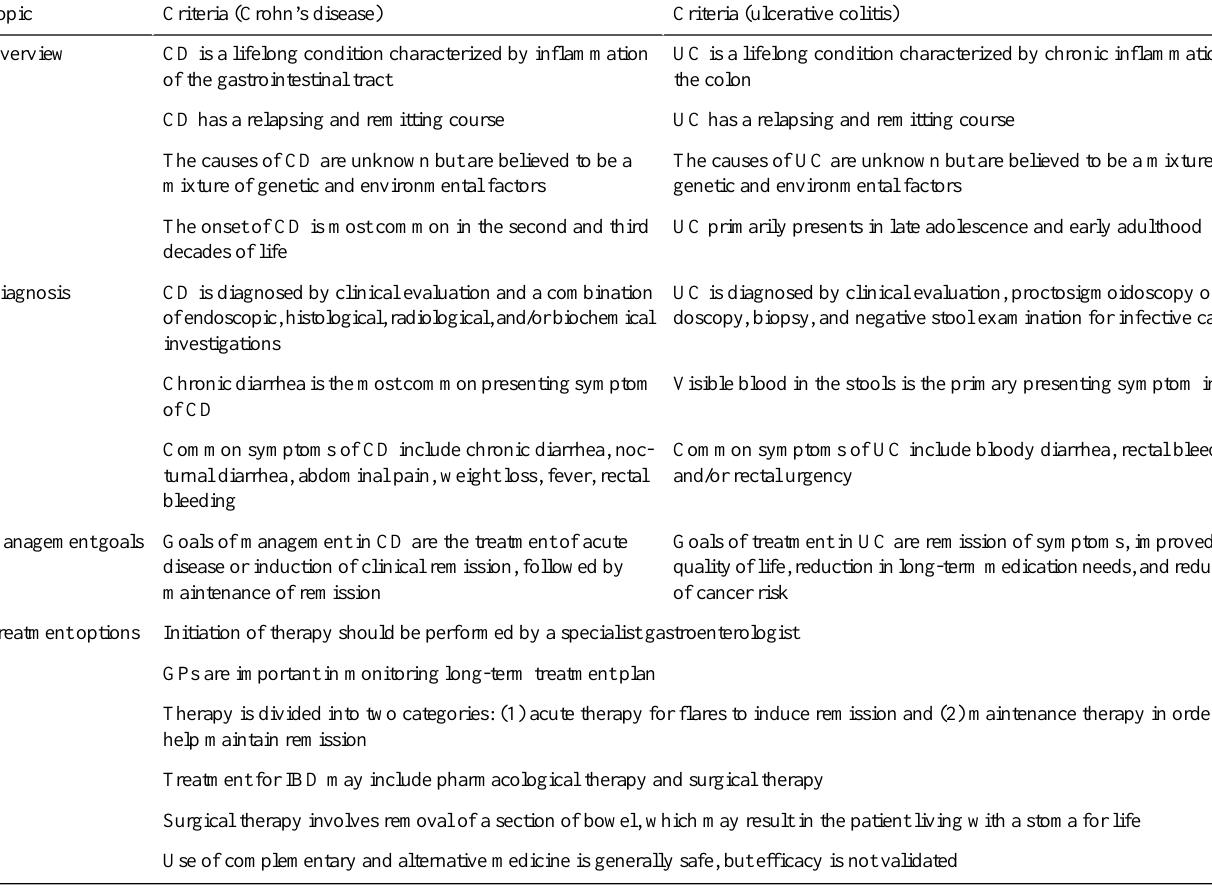
Table 2. Statements derived from international guidelines for